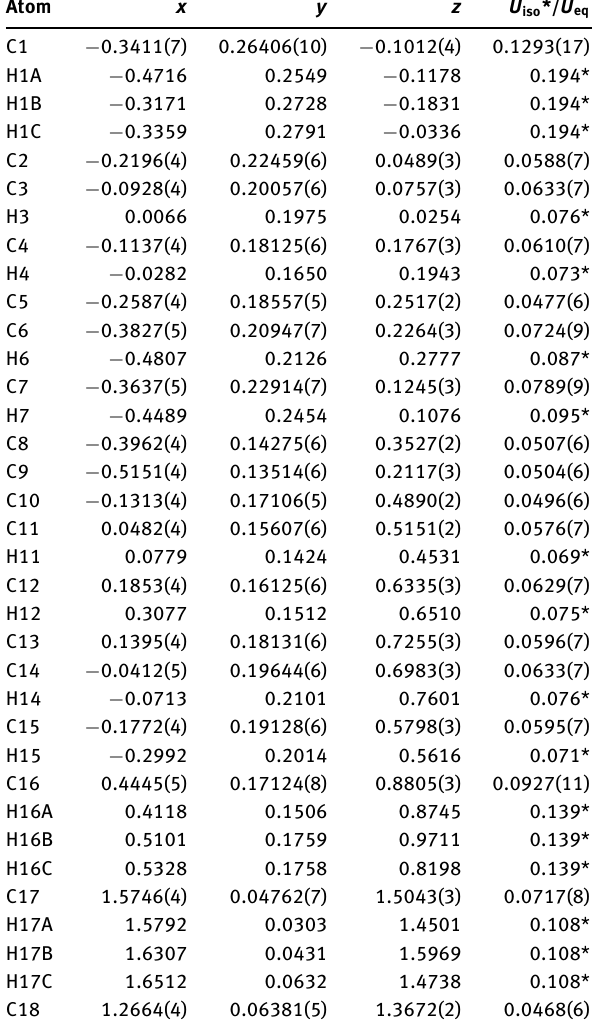
Table 2: Fractional atomic coordinates and isotropic or equivalent isotropic displacement parameters (Å 2